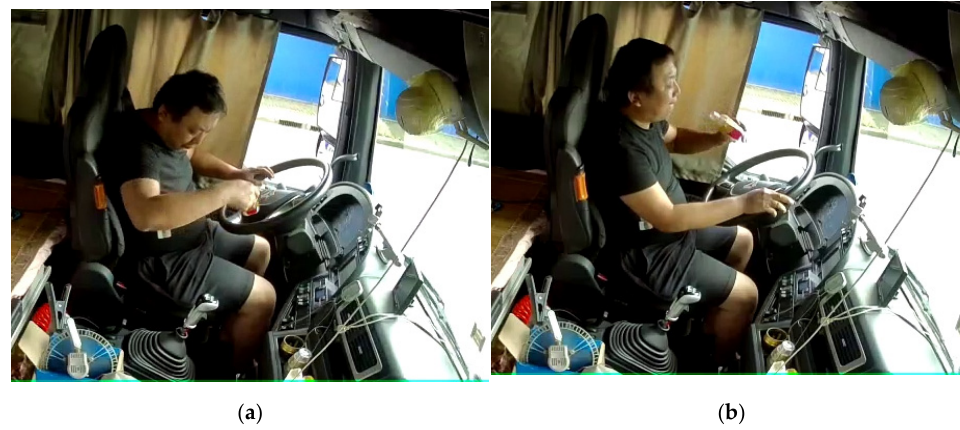
Figure 1. Commercial vehicle driver postures: ( a ) taking things; ( b ) eating or drinking